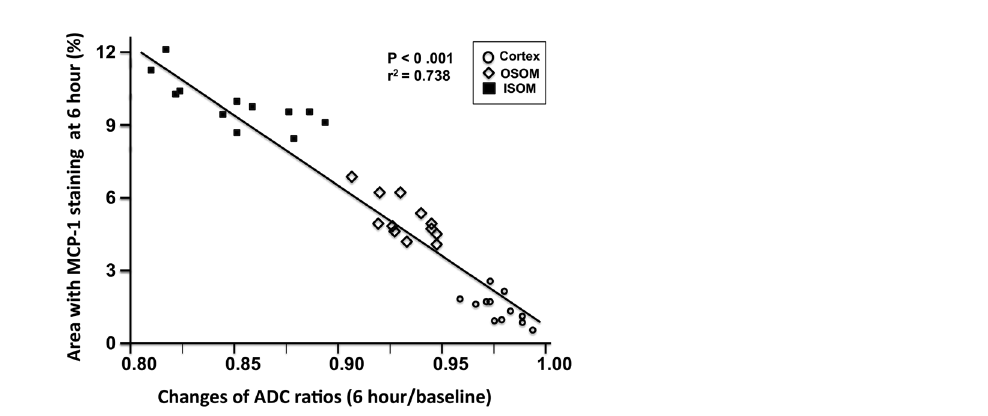
Figure 4. Immunohistochemical studies of MCP-1 in the cortex, OSOM, and ISOM of the sham, the rats at 6 hours and day 1 after IRI. MCP-1 staining (brown color) can barely be seen in the sham control in all three zones (top row). Hyperacute changes after IRI with obvious MCP-1 staining can be detected in OSOM and ISOM at 6 hours (middle row). By day 1, all three zones exhibit prolific MCP-1 staining (bottom row).